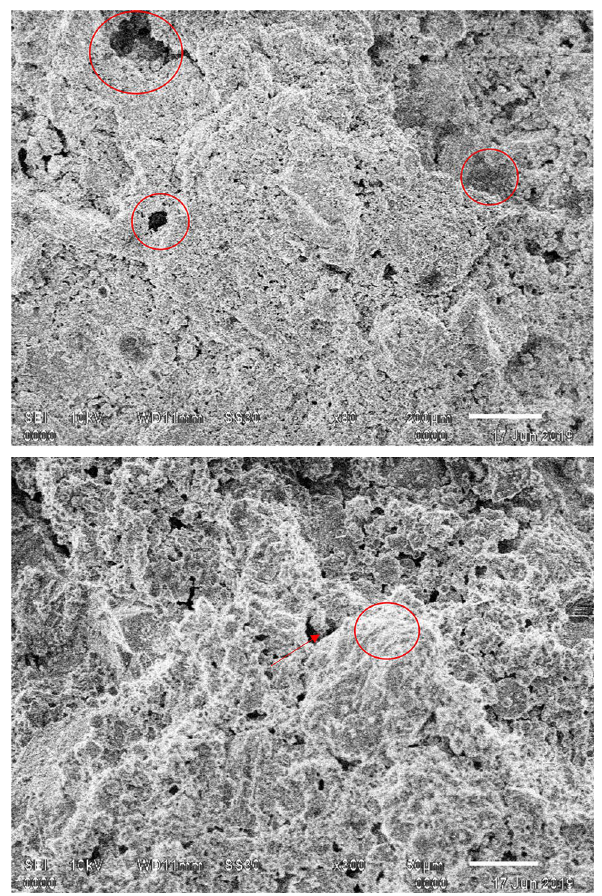
Figure 6. SEM Micrographs of green CBC